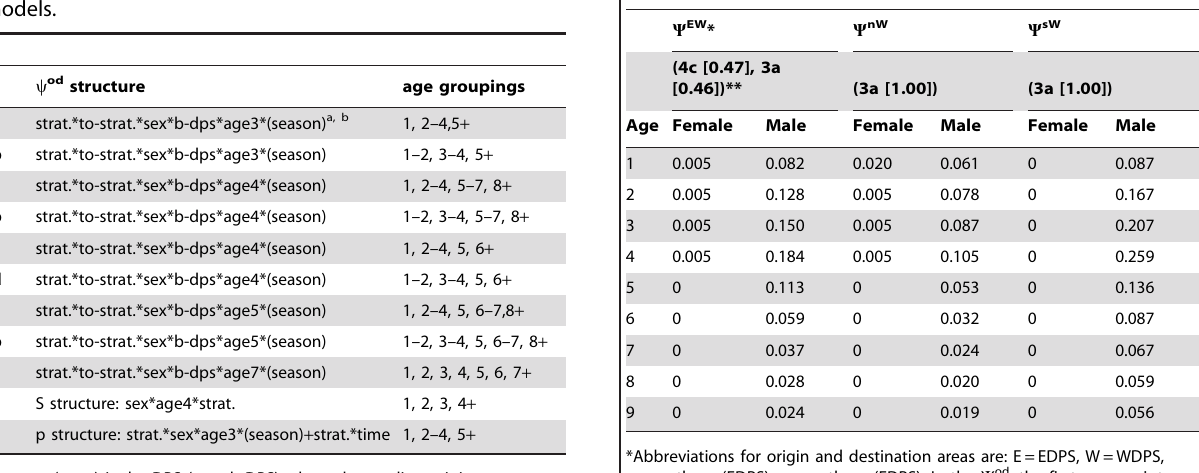
Table 2. Parameter structures for multistate mark-resight models used to predict the age-specific probabilities of Steller sea lions being present in the opposite DPS with models named after the age structure or y , the transition probabilities; the structures of S and p were the same in all models.